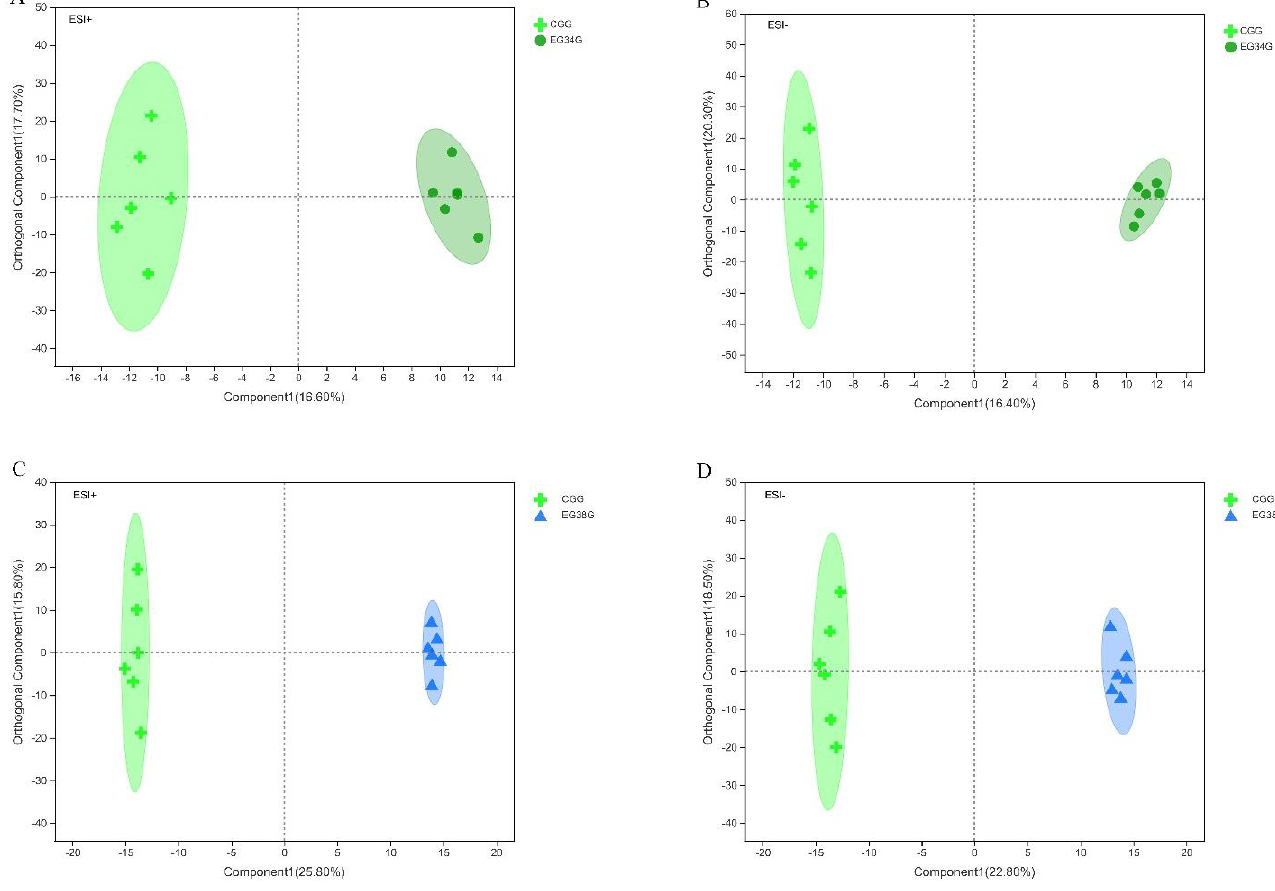
Figure 4. OPLS − DA score scatter plots: ( A ) CG vs. EG34 (ESI+); ( B ) CG vs. EG34 (ESI − ); ( C ) CG vs. EG38 (ESI+); ( D ) CG vs. EG38 (ESI − ); ( E ) EG34 vs. EG38 (ESI+); and ( F ) EG34 vs. EG38 (ESI − ). 3.3. Screening of Differential Metabolites The VIP in the OPLS-DA model (VIP > 1) and the p - value of Student’s t -test ( p < 0.05) were used to determine the different metabolites. To identify various metabolites, a Human Metabolome Database (HMDB, http://www.hmdb.ca/ accessed on 10 October 2022) information search was employed. A total of 115 upregulated and 60 downregulated metabolites were screened and identified in the CG vs. EG34 group, yielding a total of 175 differentially expressed metabolites (DEMs). The detected metabolites mainly included guanosine, xanthine, ornithine, homodolichosterone, D -ornithine, phosphatidylcholine (PC